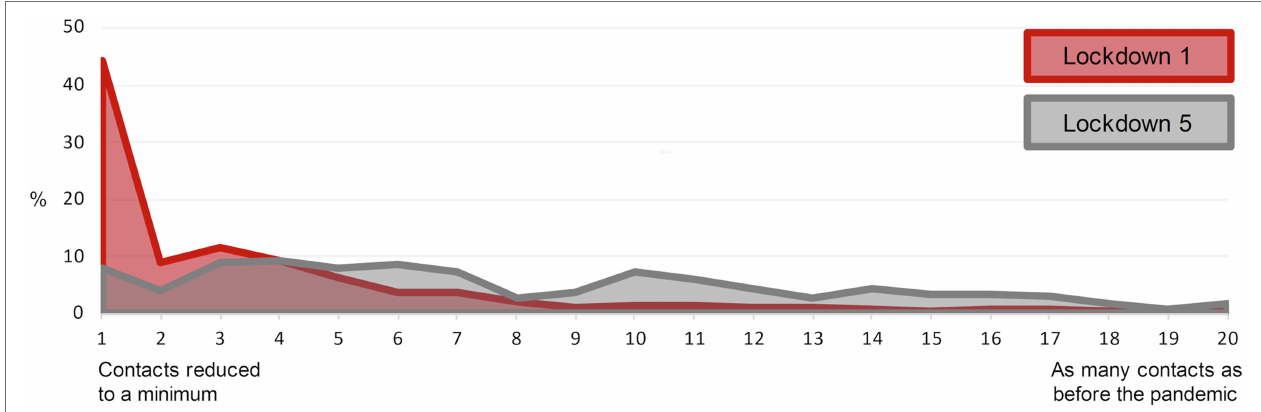
FIGURE 3 | Contacts during different lockdowns based on retrospective evaluation at Quan 2. N = 370. Contact restrictions during lockdowns was rated on a 20-point sliding